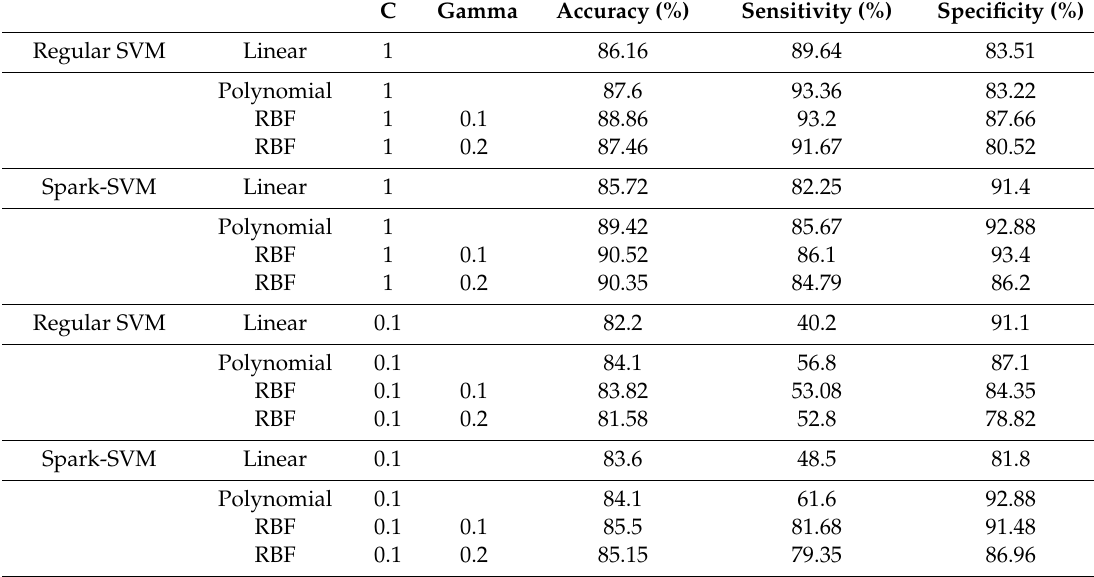
Table 1. Performance comparison of